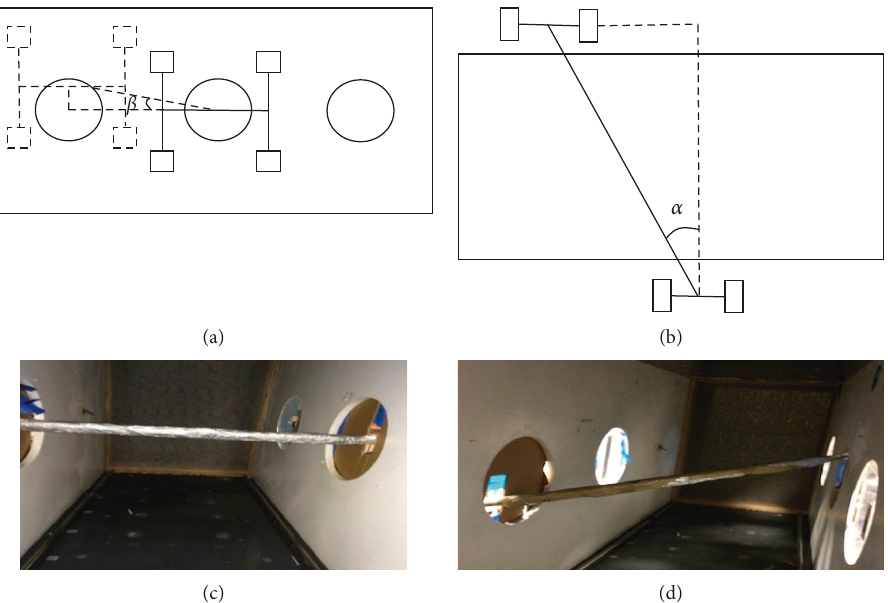
Figure 2: Cable models configuration in the wind tunnel facility: (a) front view; (b) top view; (c) α � β � 0 ° ; (d) α � 60 ° and β � 15 °